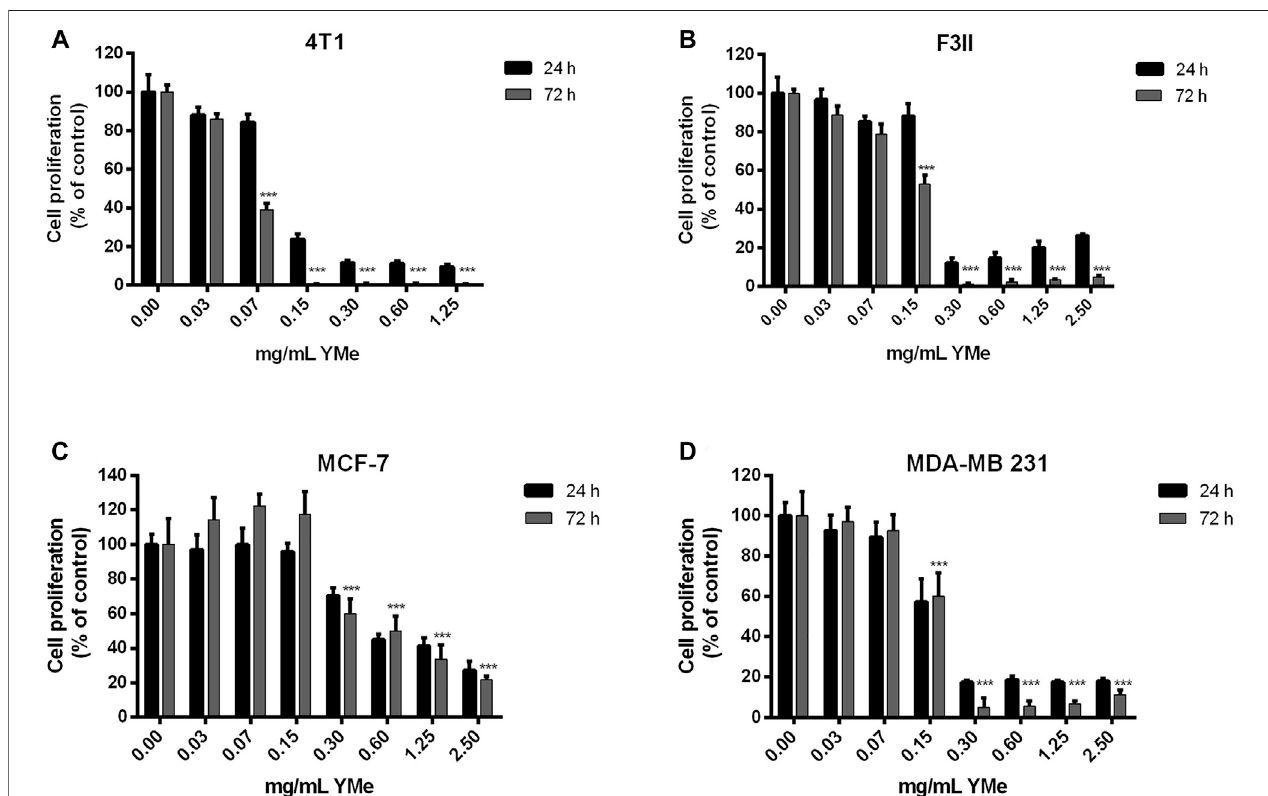
FIGURE1| Anti-proliferativeeffectofYMe.Breastcancercelllines,4T1 (A) ,F3II (B) ,MCF-7 (C) ,andMDA-MB231 (D) weretreatedwithincreasingconcentrations of YMe for 24 and 72 h. Cell proliferation was determined by a colorimetric method. Each point represents the average of six independent measurements, each done in triplicate with the standard deviation. Inhibitory concentration 50 (IC 50 ) values were calculated from the growth curves for 72 h. Statistical analysis was done using ANOVA and Tukey post-test; *** p < 0.001 vs. control.